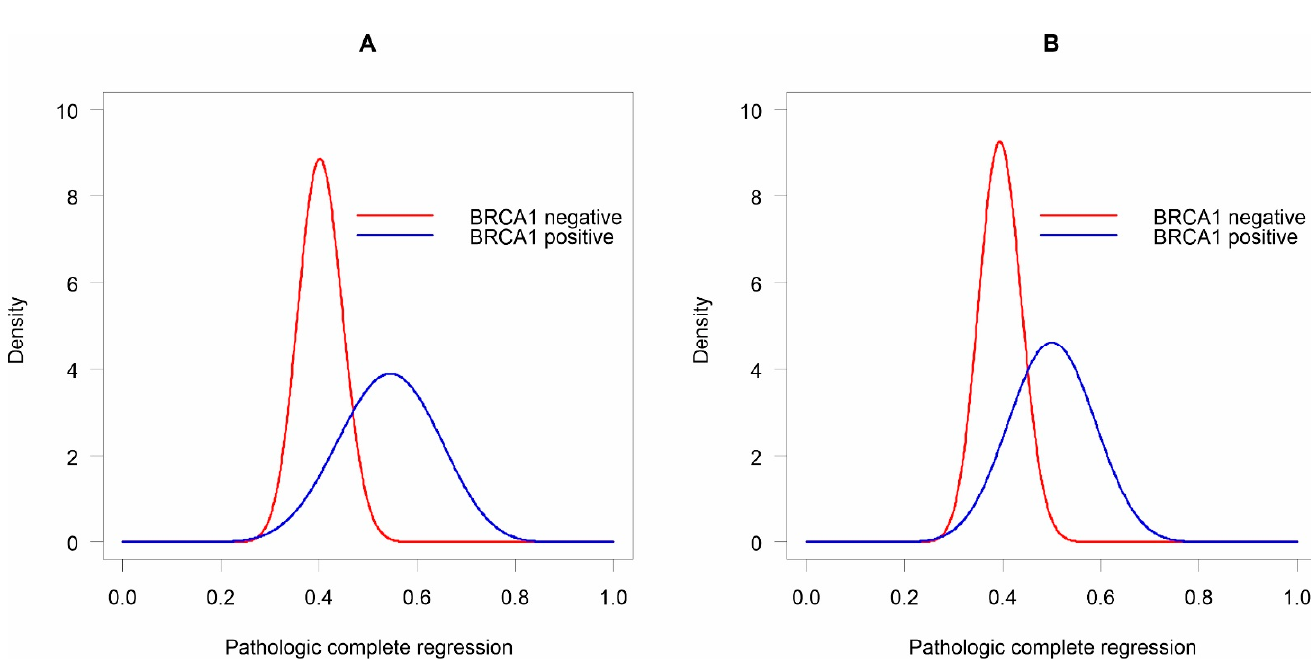
Figure 2. Beta distributions of pCR depending on the mutation status of the BRCA1 gene. The ( A ) available data, and ( B ) posterior distributions.